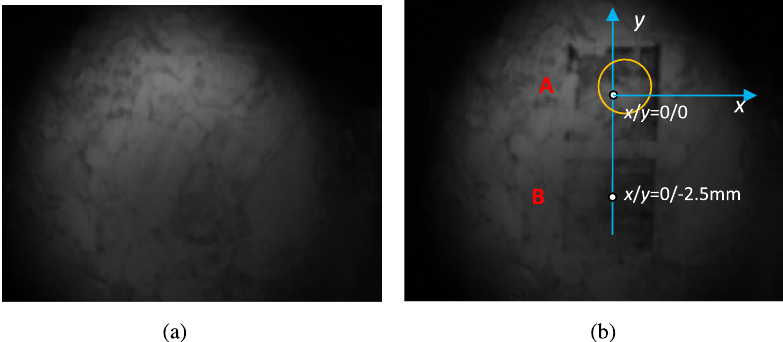
FIG. 3. White light images of the LCLS cathode before (a) and after (b) the laser cleaning. The x - y coordinate in the plot (b) is with respect to the solenoid axis.